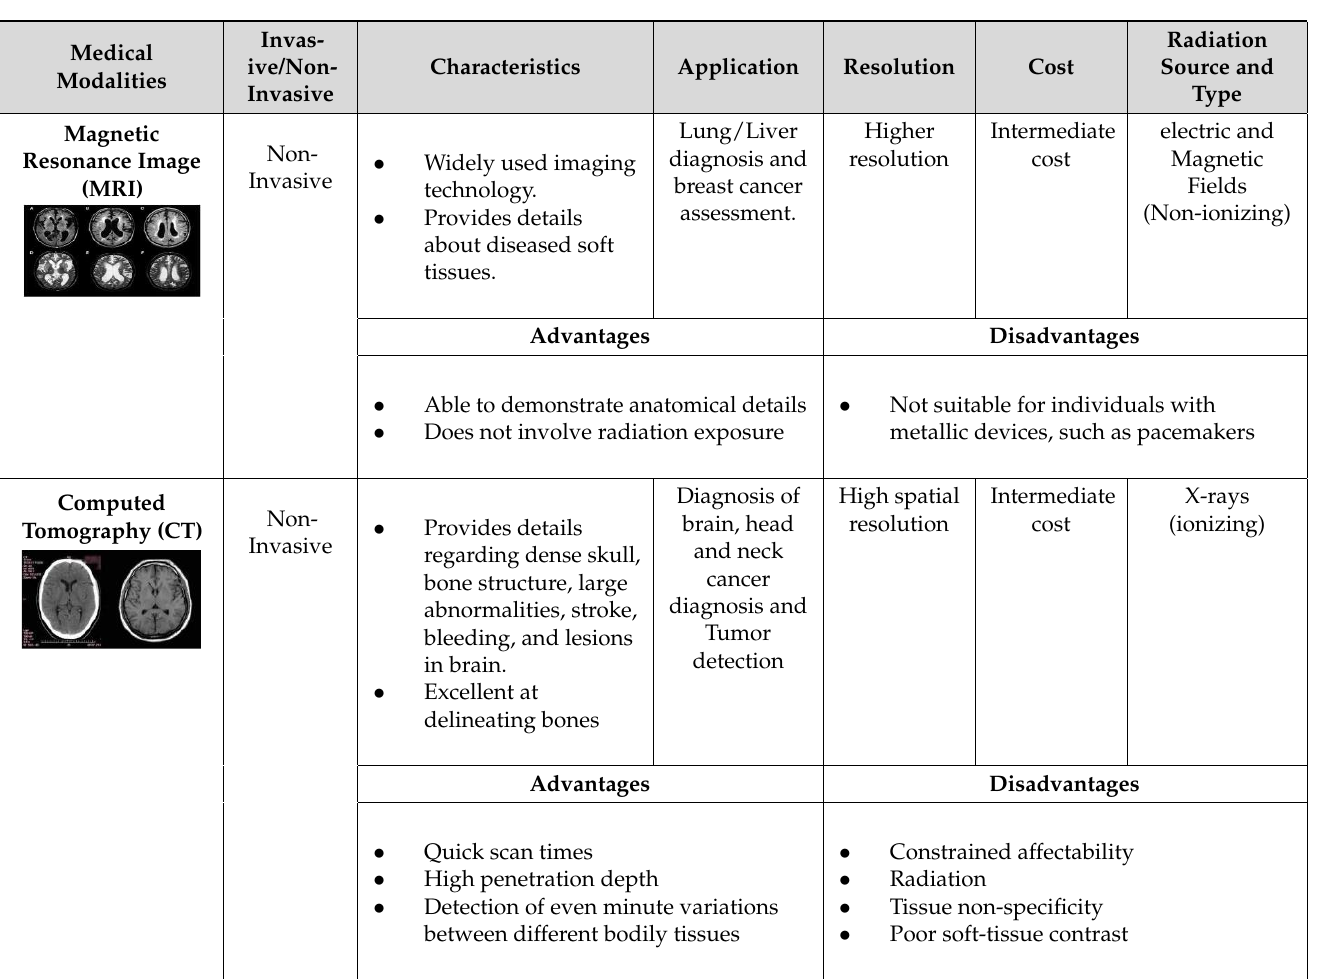
Table 1. A brief overview of various medical imaging modalities.